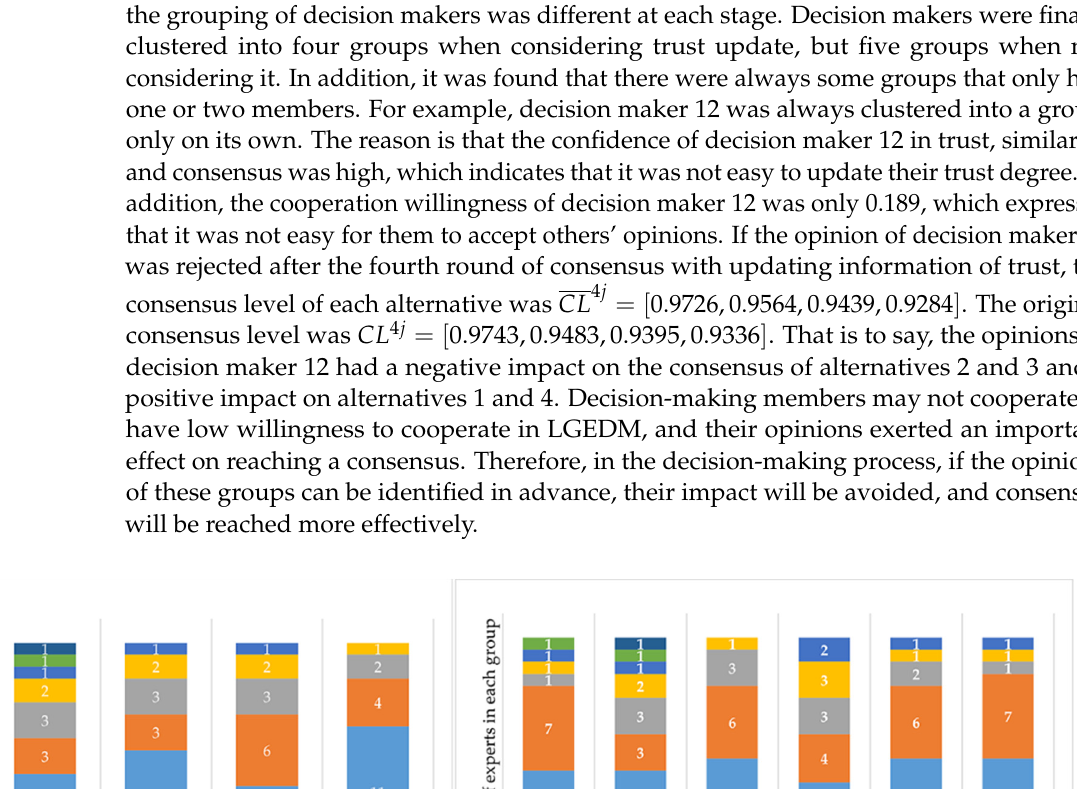
Figure 6. Consensus degree of the alternatives at each opinion interaction stage.